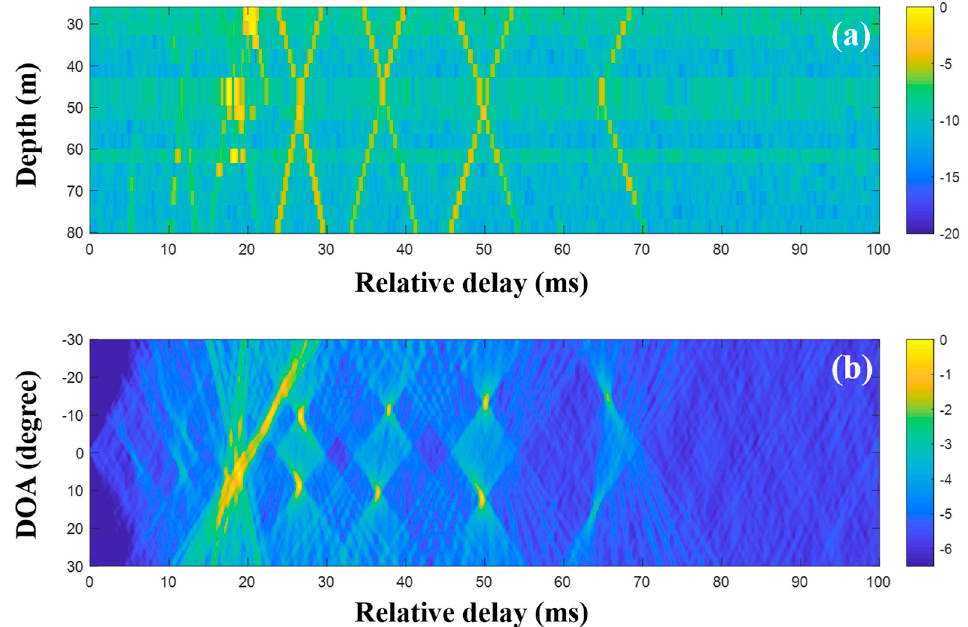
Figure 5. Direction-of-arrival (DOA) estimation using the matched filter (MF) with multiple measurements. The signal-to-noise ratio (SNR) is − 9.8 dB: ( a ) arrival structures via the application of the MF to the signals at the vertical line array (VLA) and ( b ) DOAs using delay-and-sum beamforming with the arrival structures.